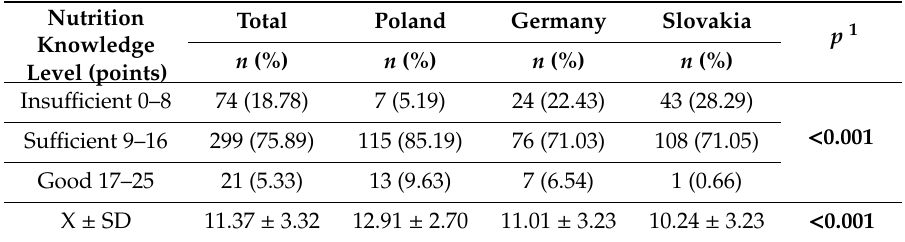
Table 4. Nutrition knowledge level (answers to the statements concerning food and